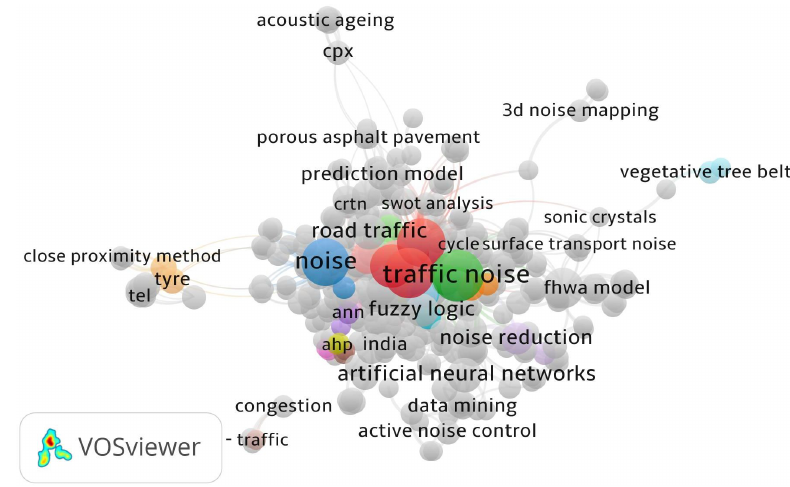
Figure 1: Network visualization of the cluster analyzing literature